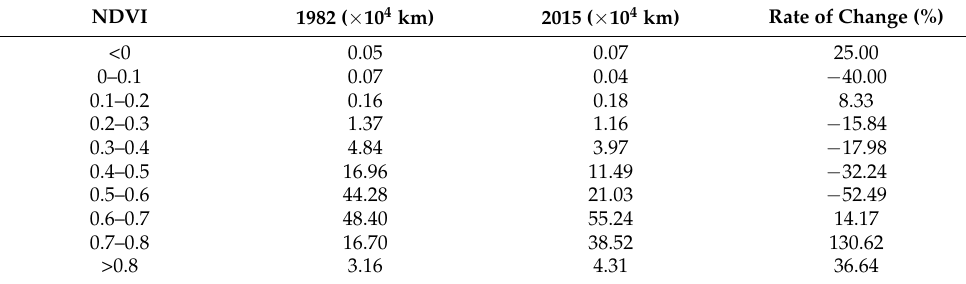
Table 2. Changes of NDVI in different range between 1982 and